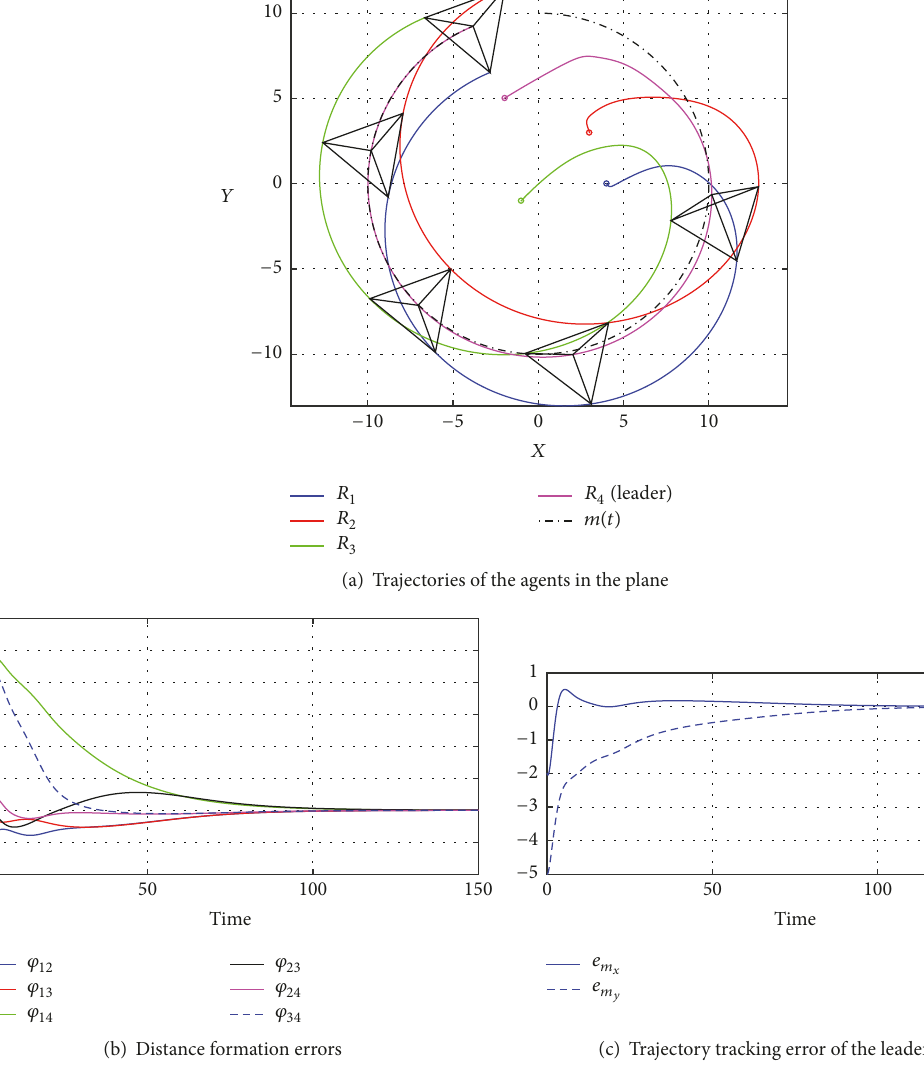
Figure 4: Simulation 1 results of distance-based formation with 𝑛 = 4 , 𝑛 1 = 2